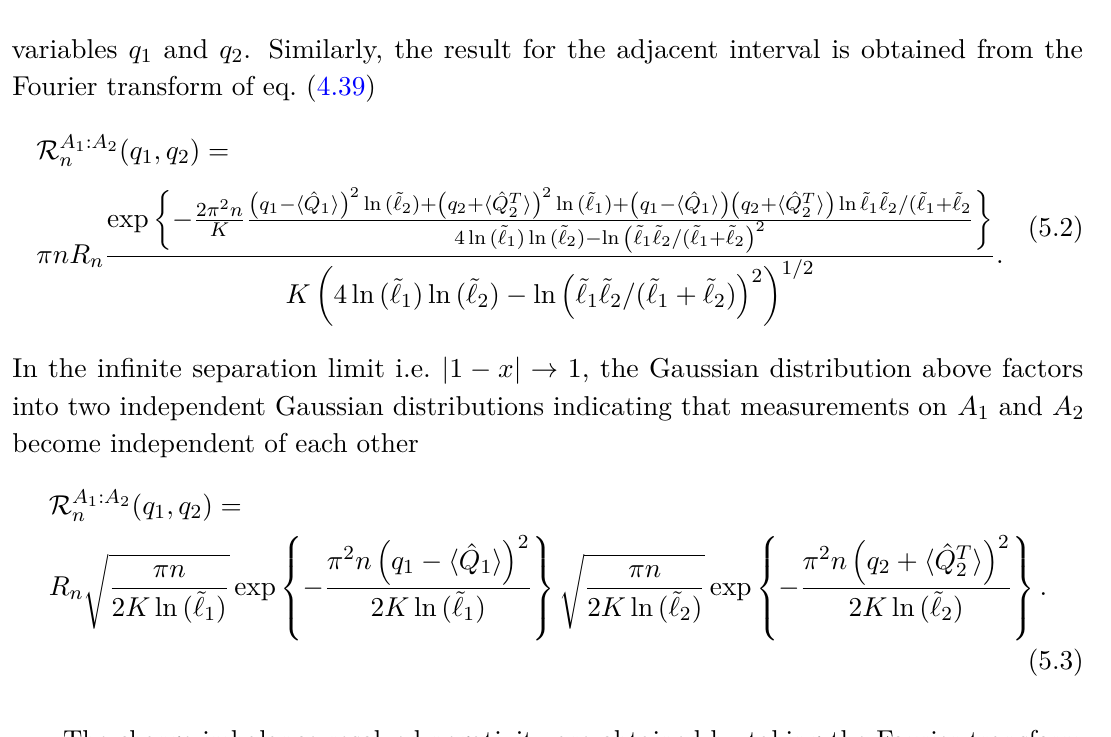
Figure 6 . Plots for charged imbalance resolved Rényi negativity for n = 1 . The continuous lines are plots of R 1 ( q ) from eq. (5.4)) with K = 1 as a function of charge q . The discrete points are the plots of numerically evaluated charged imbalance resolved Rényi negativities for tight-binding model given by plugging eq. (C.5), with β = α , in eq.